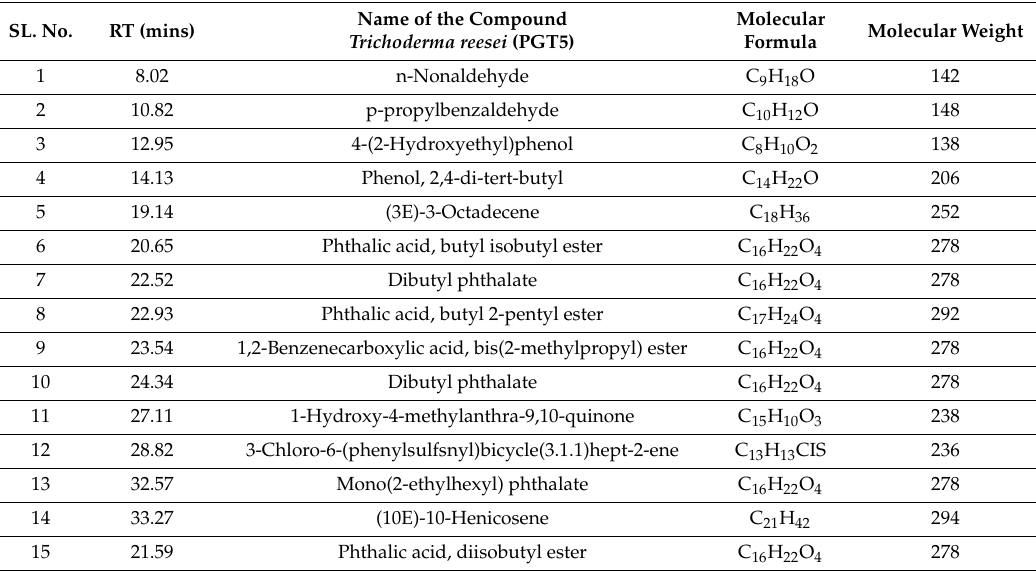
Table 3. List of compounds of Trichoderma reesei (PGT5) detected by GC-MS. RT—Retention Time. SL. No.